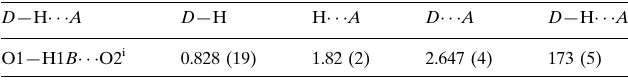
Hydrogen-bond geometry (A˚ , (cid:4)